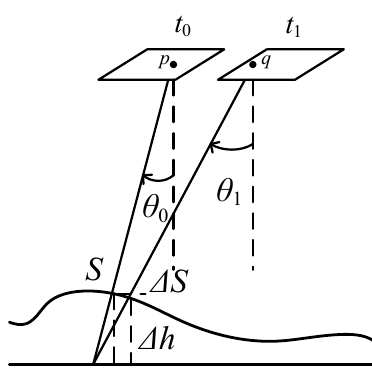
Figure 6. Schematic of the intersection of homonymous points.